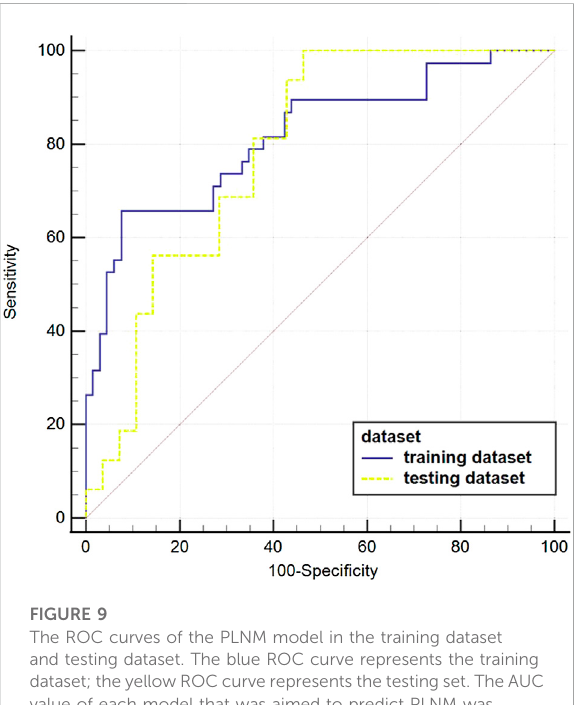
FIGURE 9 The ROC curves of the PLNM model in the training dataset and testing dataset. The blue ROC curve represents the training dataset; the yellow ROC curve represents the testing set. The AUC value of each model that was aimed to predict PLNM was 0.817 ( p < 0.001)inthetraining dataset, and 0.786( p < 0.001)inthe testing dataset.